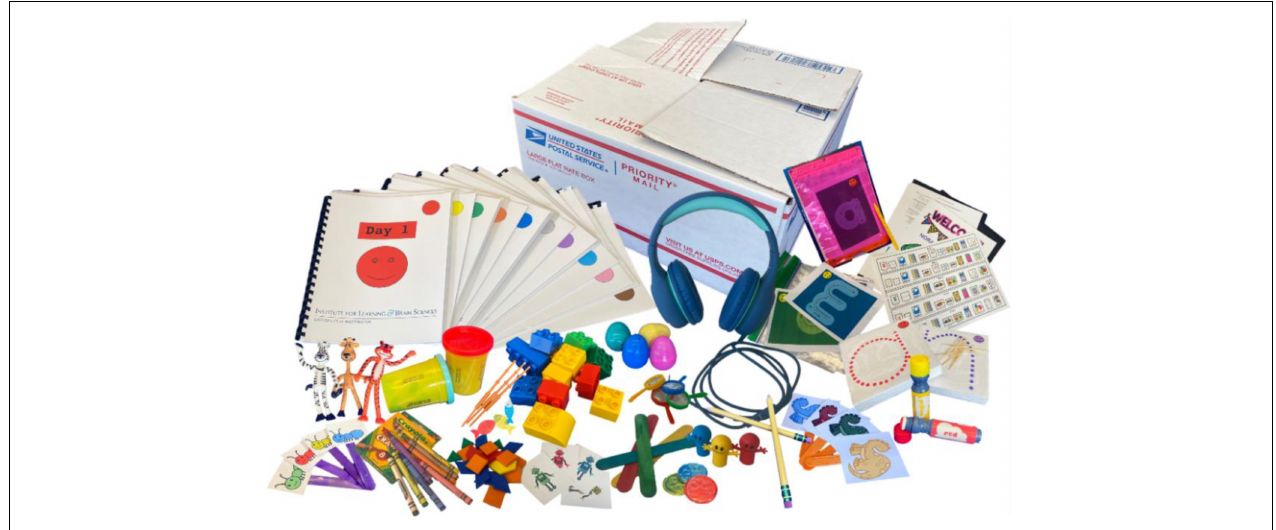
FIGURE 1 | A picture of the supply box sent to participants at home. The box includes child-sized headphones with microphones, binders with relevant worksheets, play dough, stacking building blocks, and other props used during the online Reading